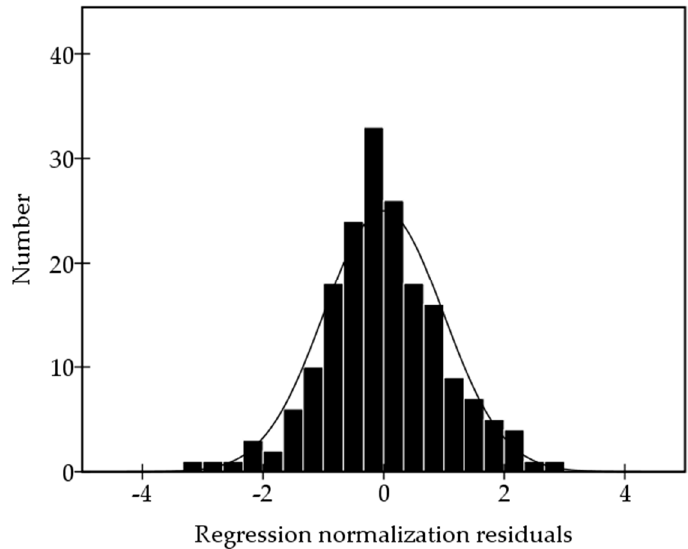
Figure 9. Residual distribution histogram.